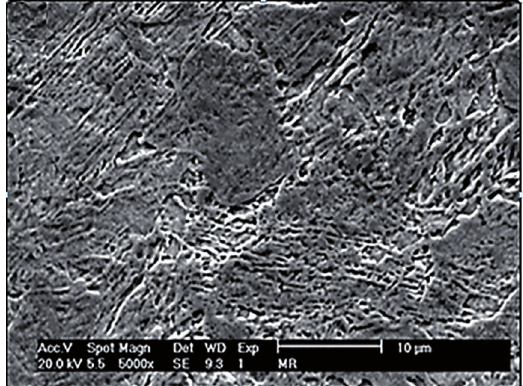
Figure 1: Maraging 300 in the “as received” condition. SEM image with 5000x magnification.